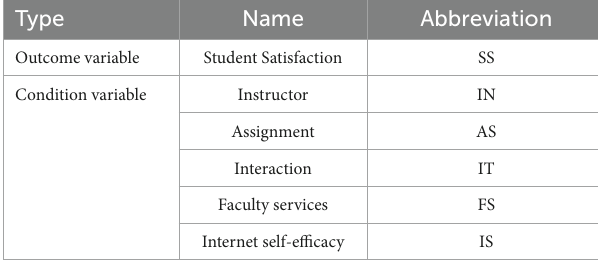
TABLE 2 Condition variable and outcome